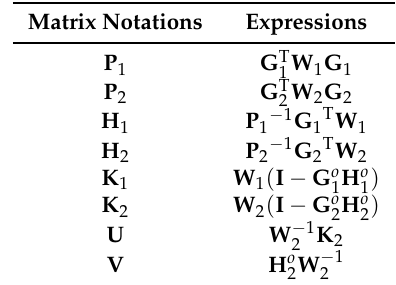
Table 2. List of matrix